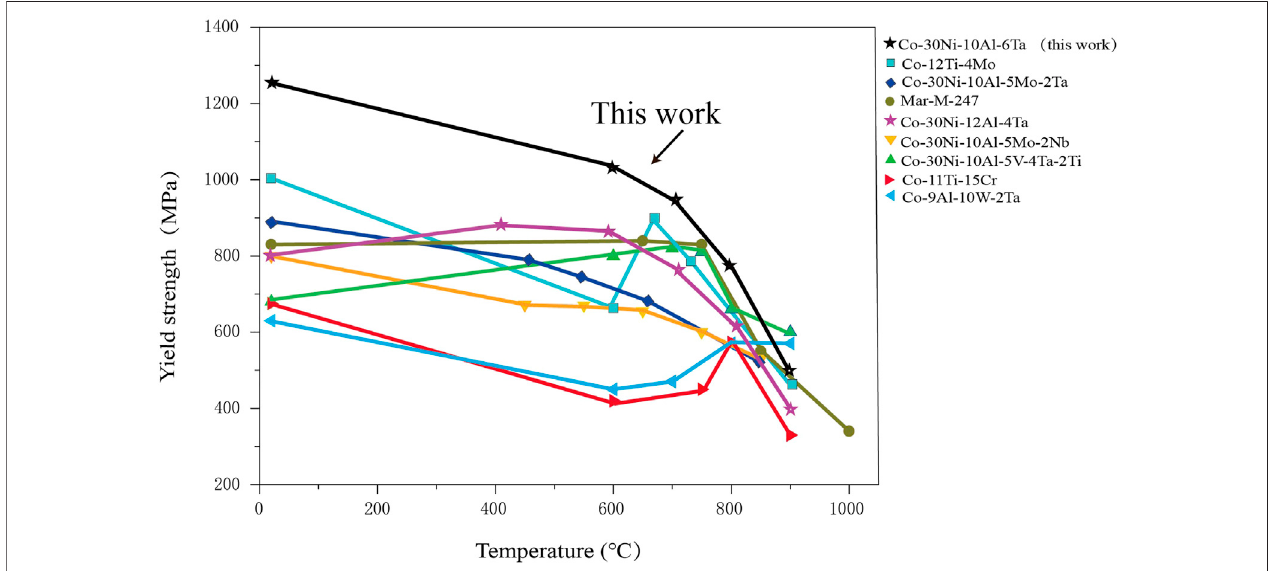
FIGURE 8 | Yield strength vs. temperature curves for Co-30Ni-10Al-6Ta, Ni-based polycrystalline Mar-M-247, Co-30Ni-10Al-5Mo-2Nb, Co-30Ni-10Al-5V-4Ta- 2Ti, Co-11Ti-15Cr, and Co-9Al-10W-2Ta superalloys.